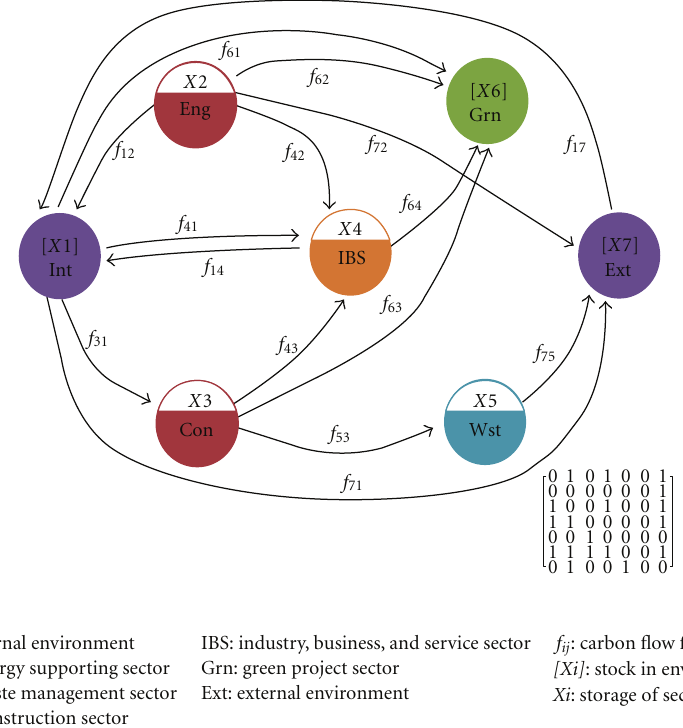
Figure 1: Metabolic network model for carbon metabolism of BDA International Business Park. The matrix at the right bottom is the adjacency matrix A of the model, where A = [ a ij ]. If there exists a carbon flow from compartment j to i , a ij = 1, else a ij =